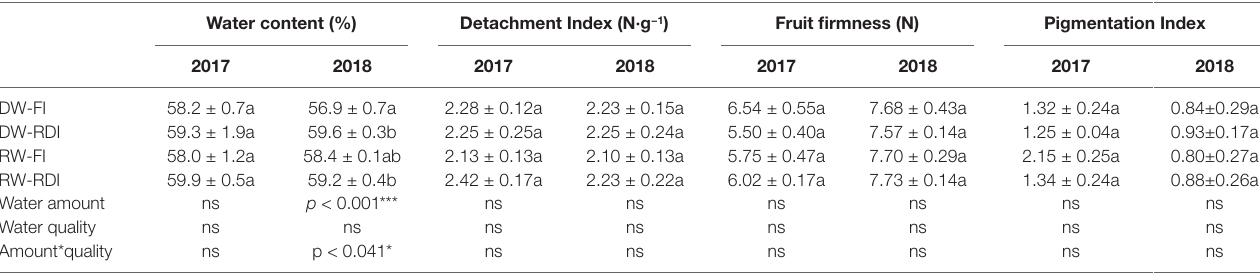
TABLE 2 | Ripening indices: water content, detachment index, fruit firmness and pigmentation index for each treatment: DW-FI (DESERT water-full irrigation), DW-RDI (DESERT water-regulated deficit irrigation), RW-FI (reclaimed water-full irrigation) and RW-RDI (reclaimed water-regulated deficit irrigation) in 2017 and 2018. Water content